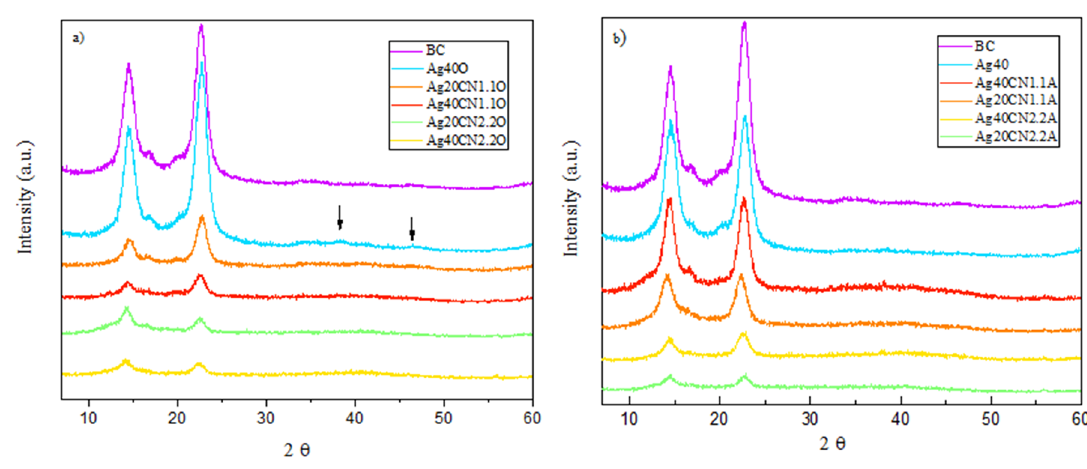
46.5° (indicated by the arrows in Fig. 7a) in the membrane containing only AgNPs and thermally treated in an oven (sample Ag40O). These two diffraction peaks at 38.3° and 46.5° can be attributed to metallic silver corresponding to the crystallographic planes (111) and (200), respectively 24 . It was not possible to observe the characteristic peaks of AgNPs and Ce(NO ) in the other membranes due to the low 3 3 concentration of these substances in the samples.